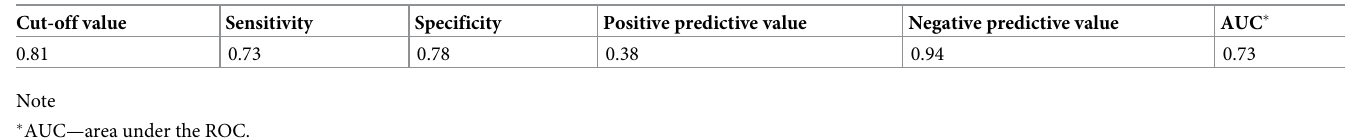
Table 4. The ROC analysis of podocin relative to the kidney disease in horses.